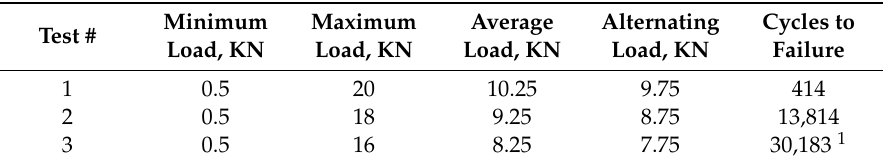
Table 1. Results of tests at 640 ◦ C.